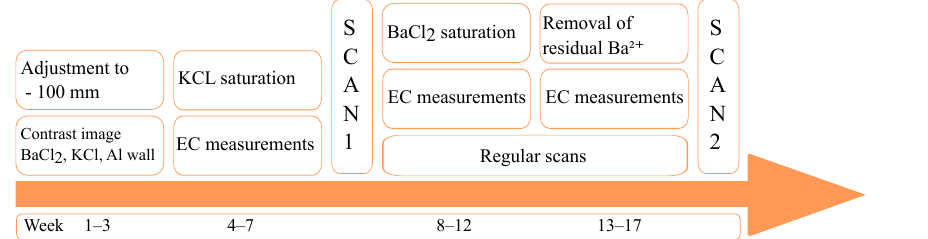
Figure 3. Experimental time schedule. X-ray scans were performed after KCl treatment to obtain the reference image (Scan 1) and after removal of residual Ba 2 + ions to obtain the Ba 2 + -subjected image (Scan 2).